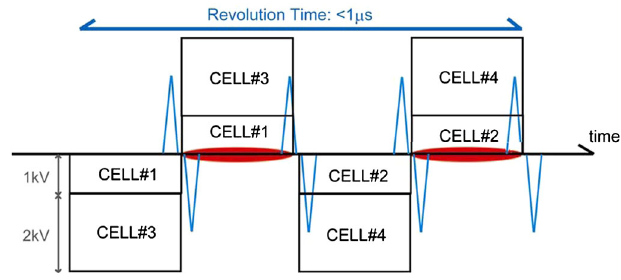
FIG. 33. In the third stage ( T r < 1 (cid:1) s ), two pairs of type A and B ICs are operated